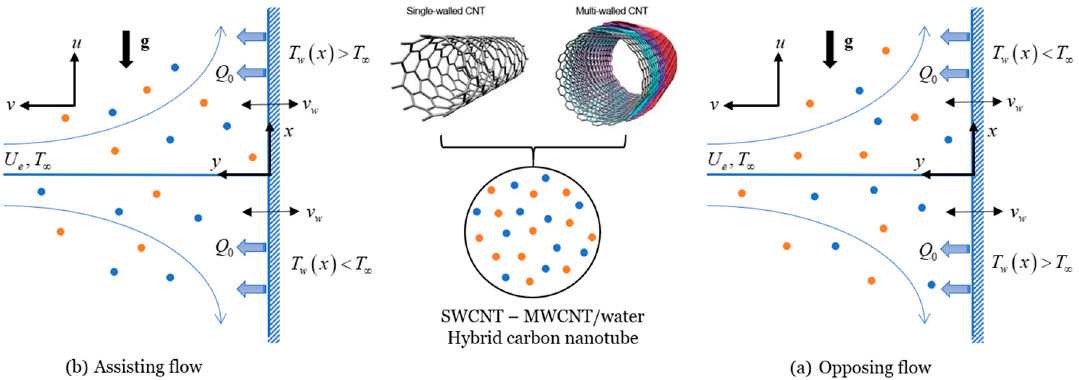
Figure 1. Physical Figure 1. Physical model.